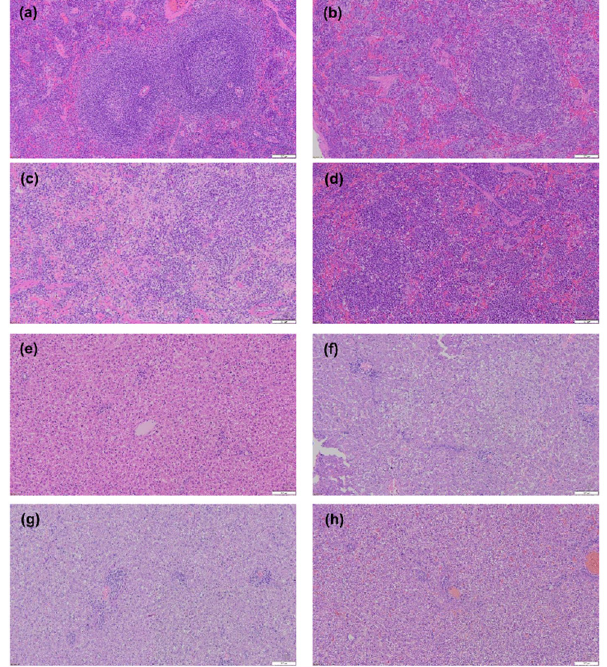
Figure 3. Histopathological observations of tissues from ferrets infected via IM, SC, and IV routes with PBS or 10 5 FFU SFTSV. The spleen ( a – d ) and liver ( e – h ) samples were harvested at 6 dpi in the mock ( a , e ), IM ( b , f ), SC ( c , g ), and IV ( d , h ) groups. Bars, 100 µm.